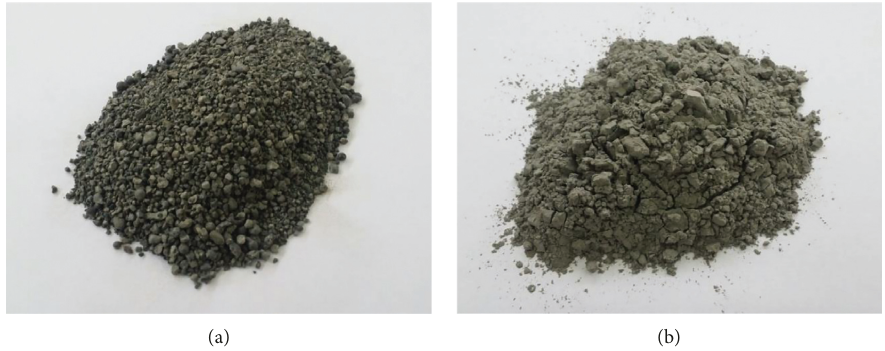
Figure 1: Ferronickel slag sample: (a) ferronickel slag aggregate; (b) ferronickel slag powder.